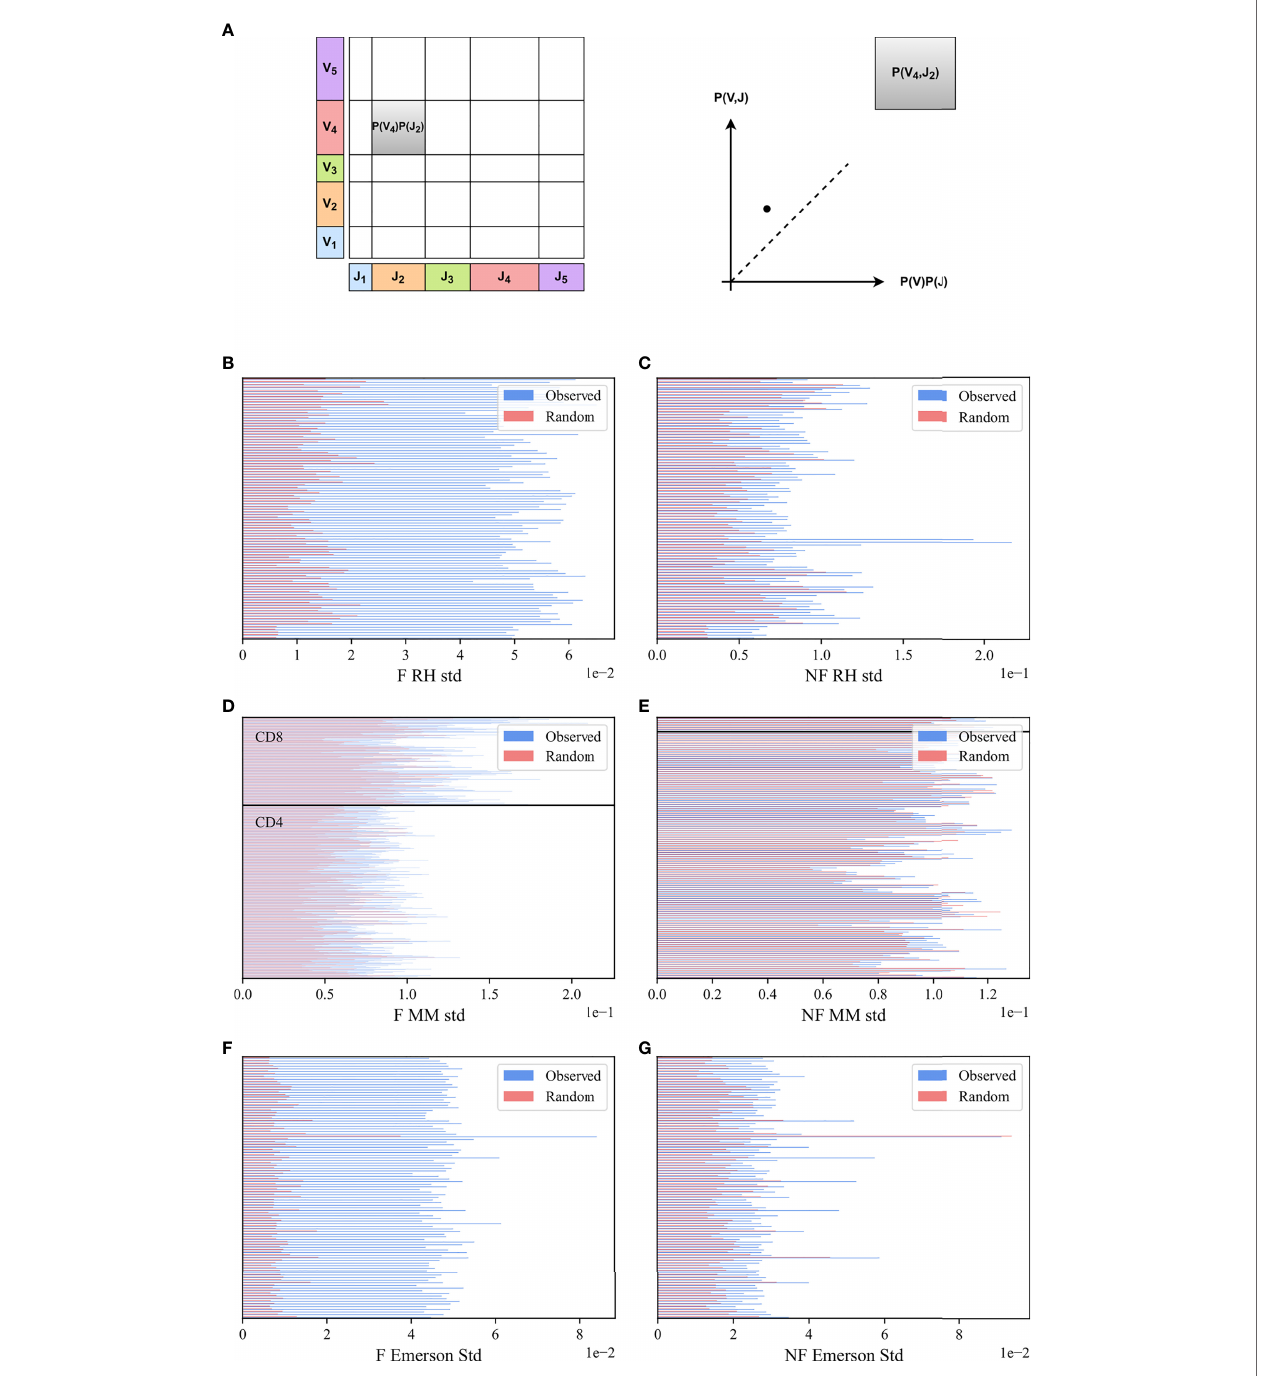
FIGURE 2 | M ( V b , J b ) bias. (A) Schematic explanation M ( V b , J b ) measure. We computed the marginal frequency in a sample of J b and V b (X and Y axes), de fi ned to be the fraction of clones using each. We then computed their product (size of rectangles), and compared this product with the actual number of clones that use a given V b , J b pair. (B, C) The standard deviation of M ( V b , J b ) values for the RH dataset. The blue bars describe the real F clones values (B) and the real NF clones values (C) while the pink bars represent the null model. (D, E) The standard deviation of M ( V b , J b ) values for the MM dataset, with the same colors. All samples above the black line are CD8 T-cells, and below are CD4 T-cells. (F, G) Same results for the Emerson